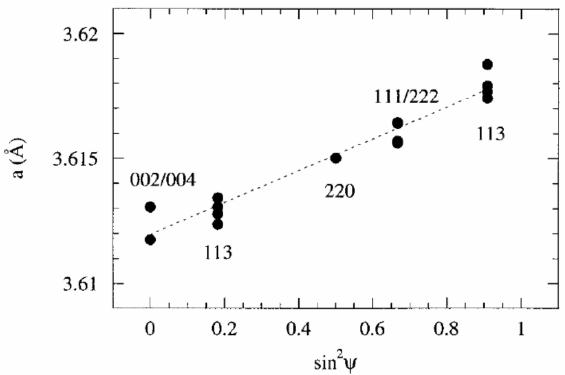
Figure 2. The Sin2 ψ law in a monocrystalline Cu film with an orientation of (001) deposited on silicon [33]. The positive slope is proportional to the residual tensile stress present in the film. Reprinted from